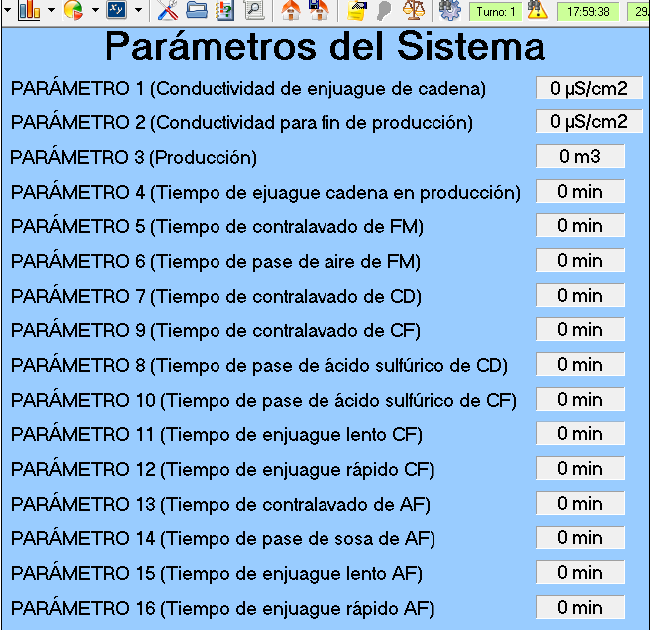
Figure 8: Parameters Interface. Source: Authors, (2020).